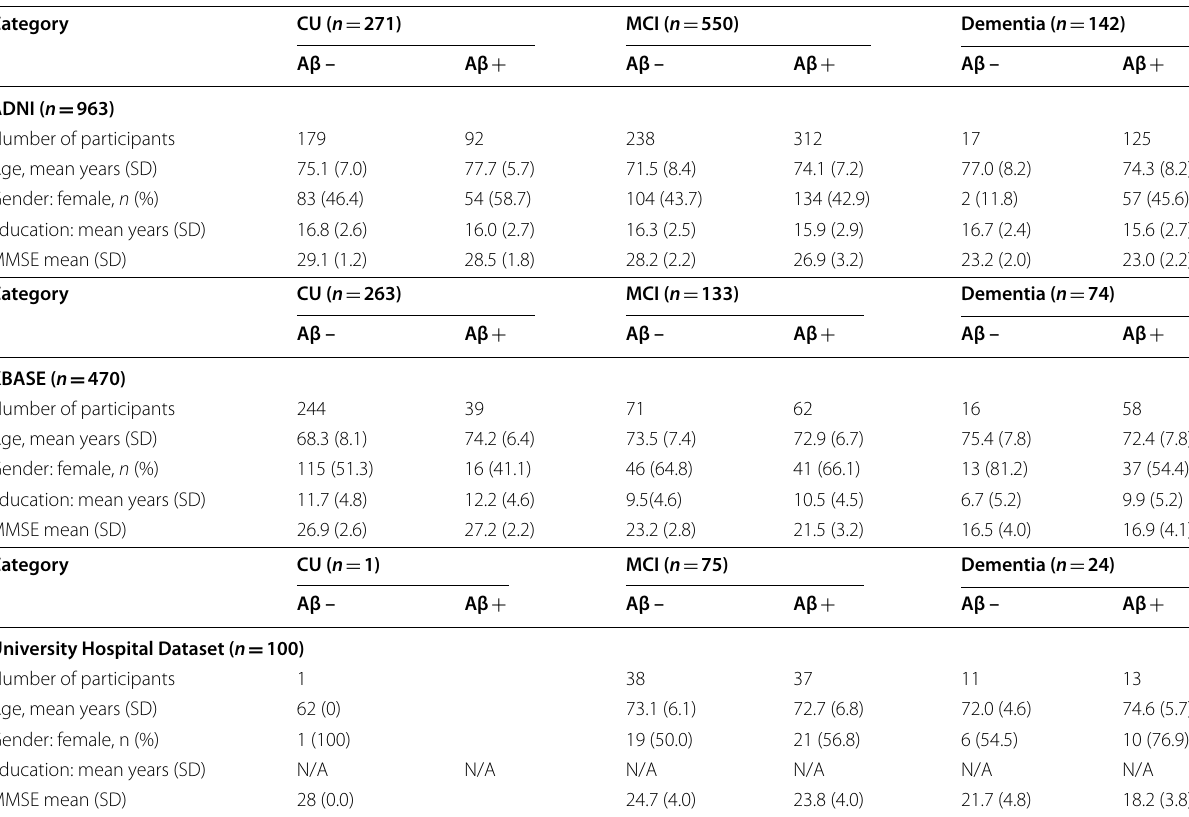
Table 1 Dataset demographics and clinical